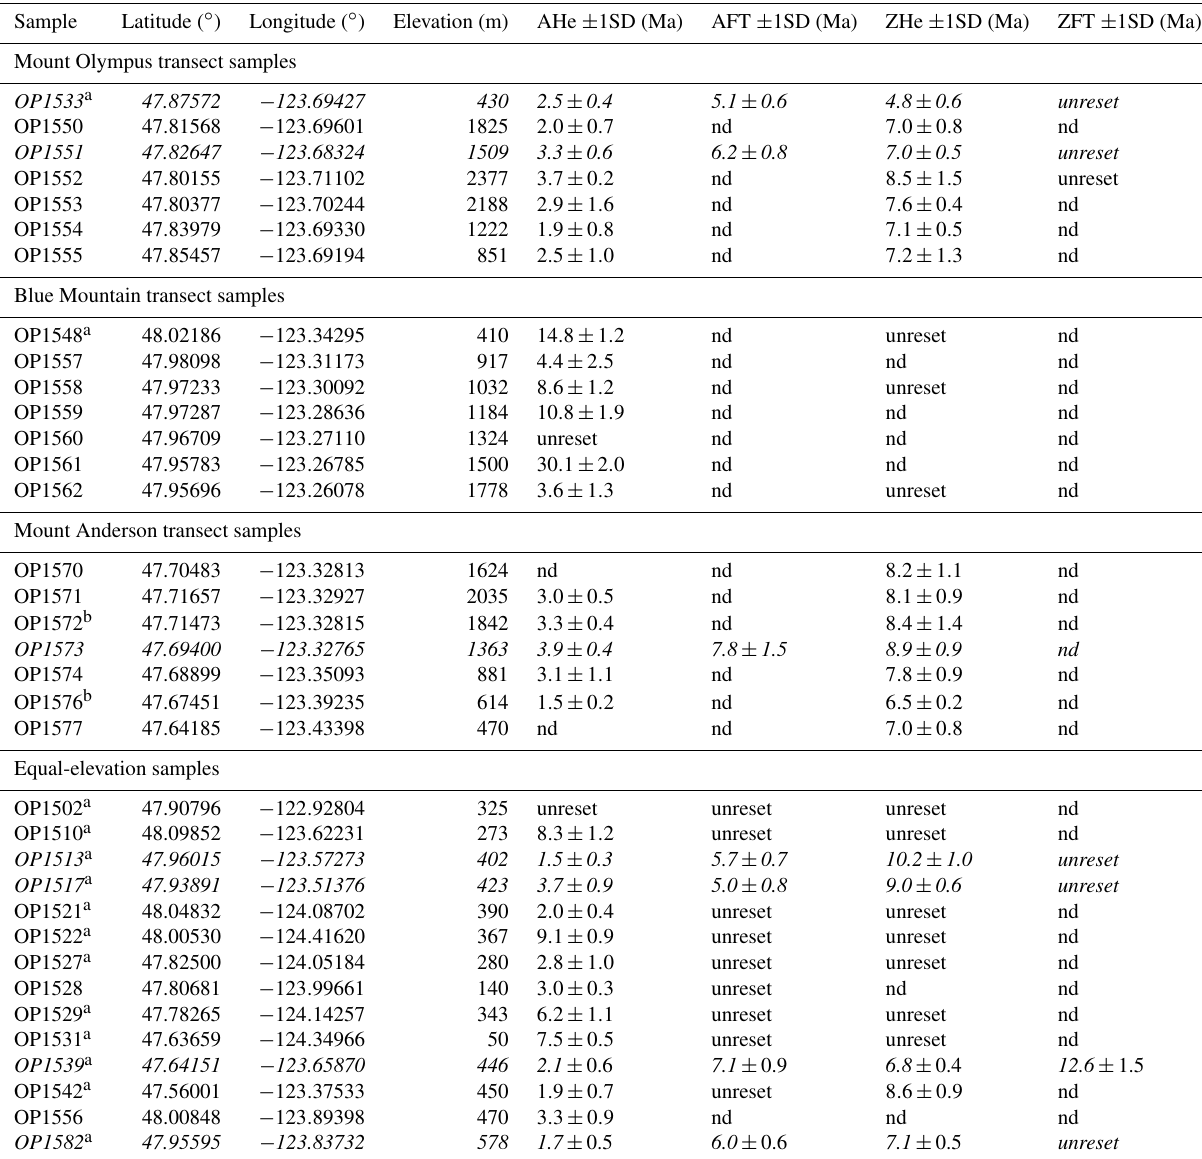
Table 2. Coordinates, elevations, and thermochronometric cooling ages for samples considered in this study.